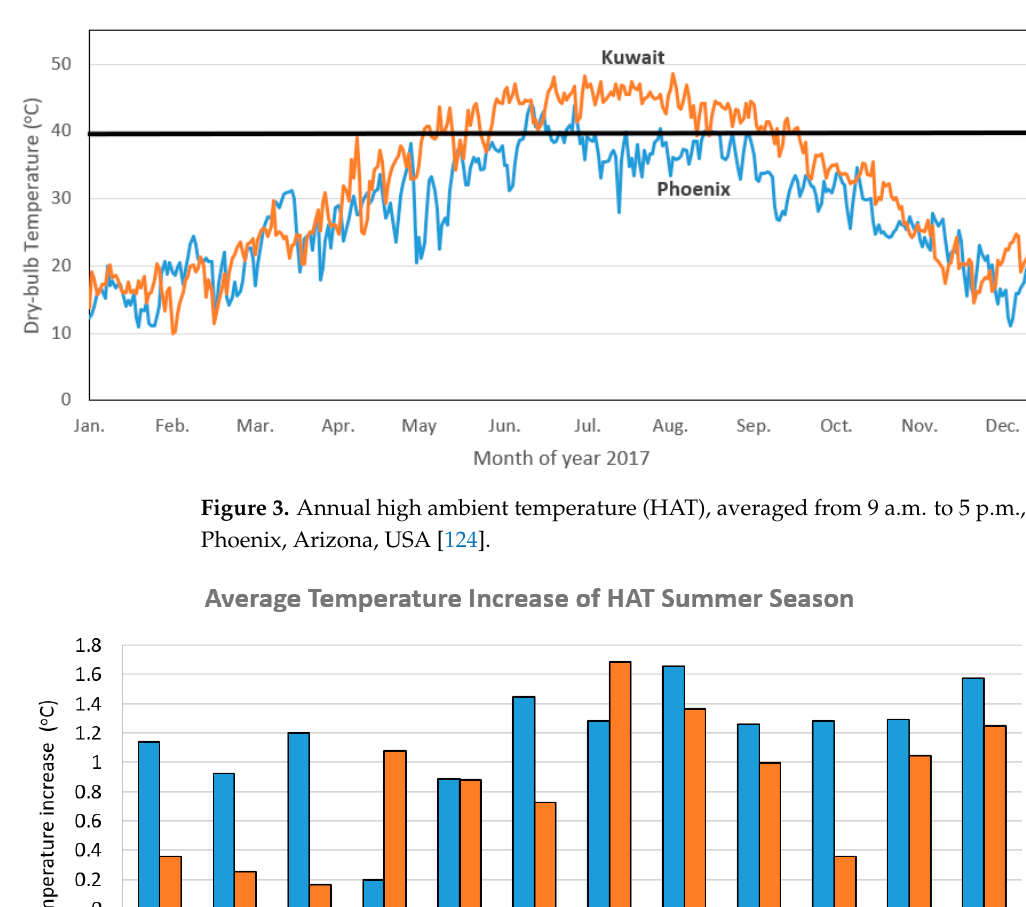
Figure 2. Hourly temperature distribution for Phoenix, Arizona, USA and Kuwait in 2017 [124].